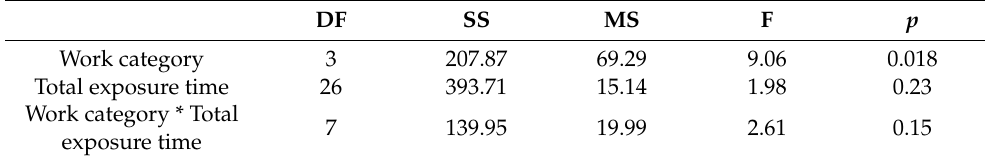
Table 2. Analysis of variance model of bio-contaminants by work category and total exposure time. DF SS MS F p